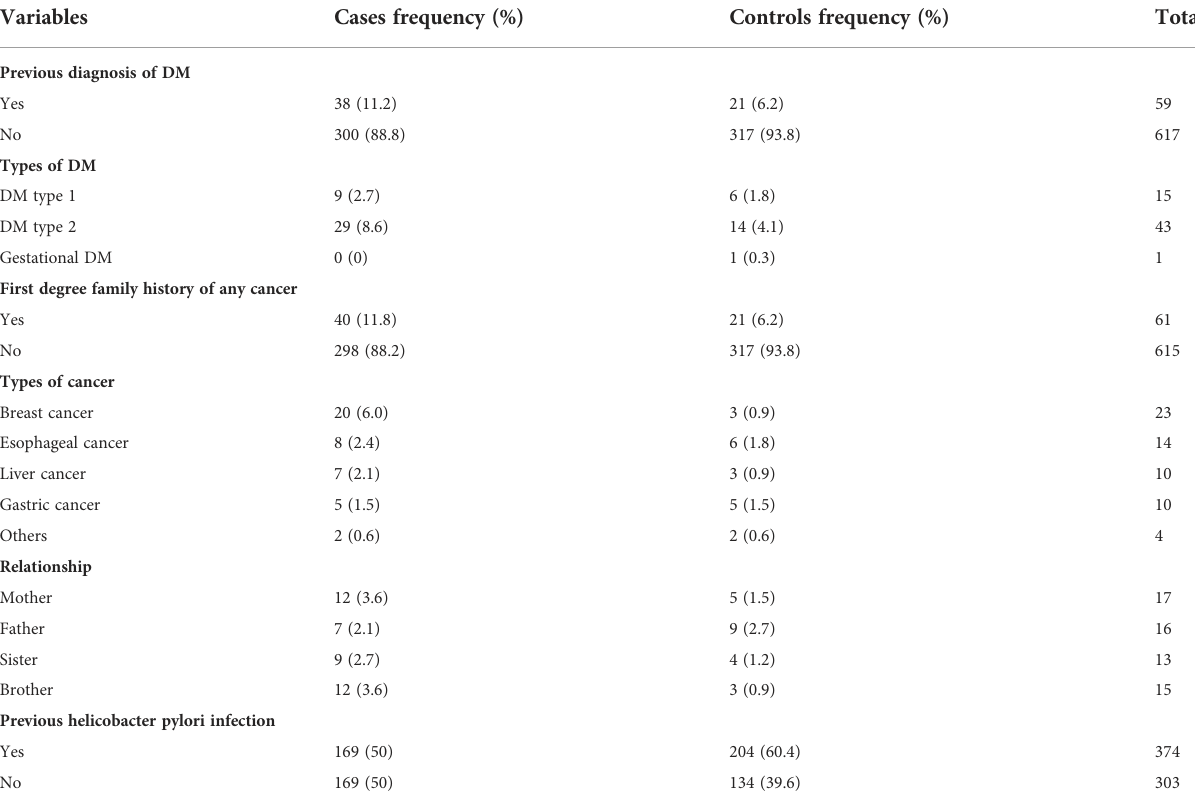
TABLE 4 Comorbidity pro fi le of cases and controls, February 2019-August 2020, Addis Ababa,